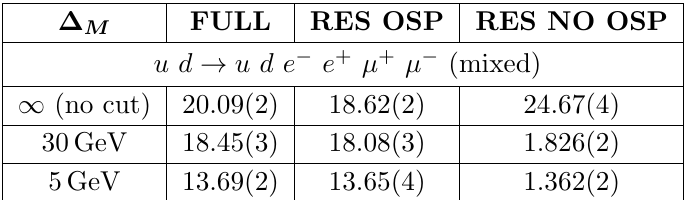
u d e (cid:0) e + (cid:23) (cid:22) (cid:22) + , for M M Z < (cid:1) M ( ‘ = e; (cid:22) ). ‘ + ‘ (cid:0) (cid:0) ! j j > 20 GeV ; (cid:17) j < 5 : 5 ; M jj > 600 GeV ; (cid:1) (cid:17) jj > 3 : 6 ; M 4 ‘ > t j j j j